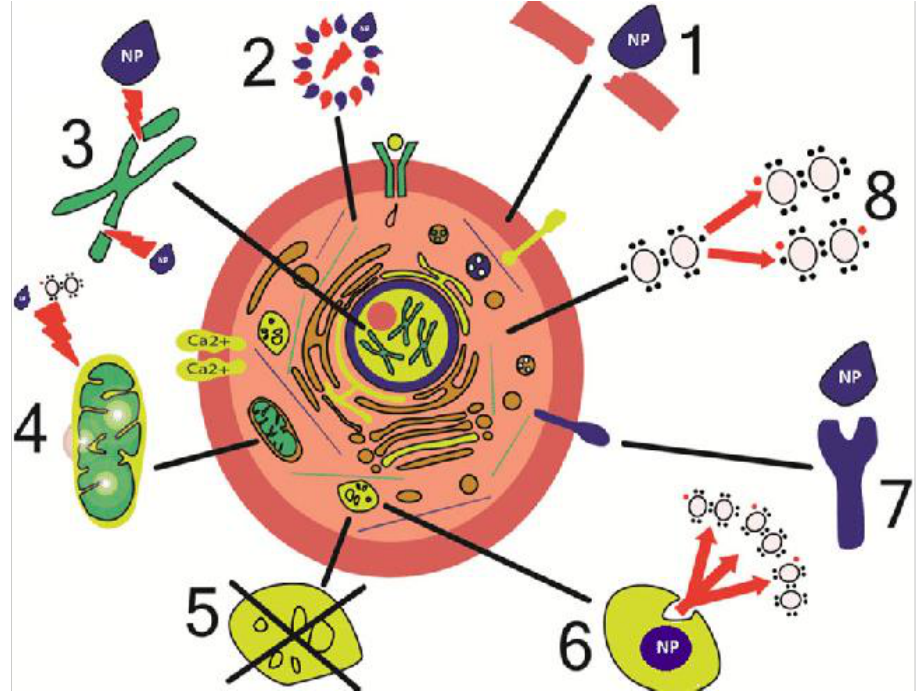
Figure 15. Mechanisms of cell damage by nanoparticles. (1) Physical damage of membranes. (2) Structural changes in cytoskeleton components. (3) Disturbance of transcription and oxidative damage of DNA. (4) Damage of mitochondria. (5) Disturbance of lysosome functioning. (6) Generation of reactive oxygen species. (7) Disturbance of membrane protein functions. (8) Synthesis of in- flammatory factors and mediators. Adapted from Ref. [124], copyright 2018, with permission from Springer